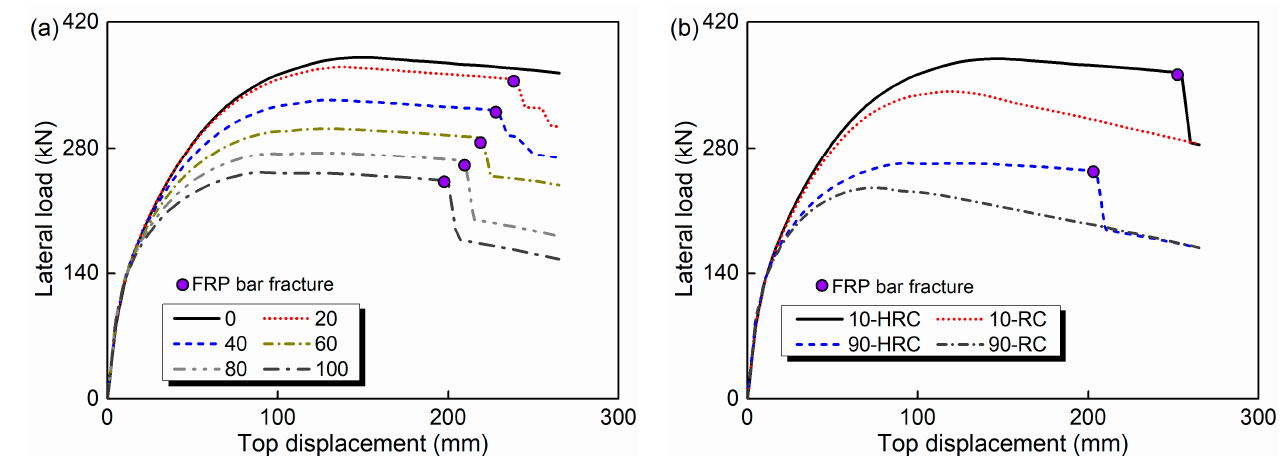
Figure 11. Time-dependent lateral load-top displacement envelope curves: ( a ) HRC bridge column; ( b ) HRC and RC bridge column.